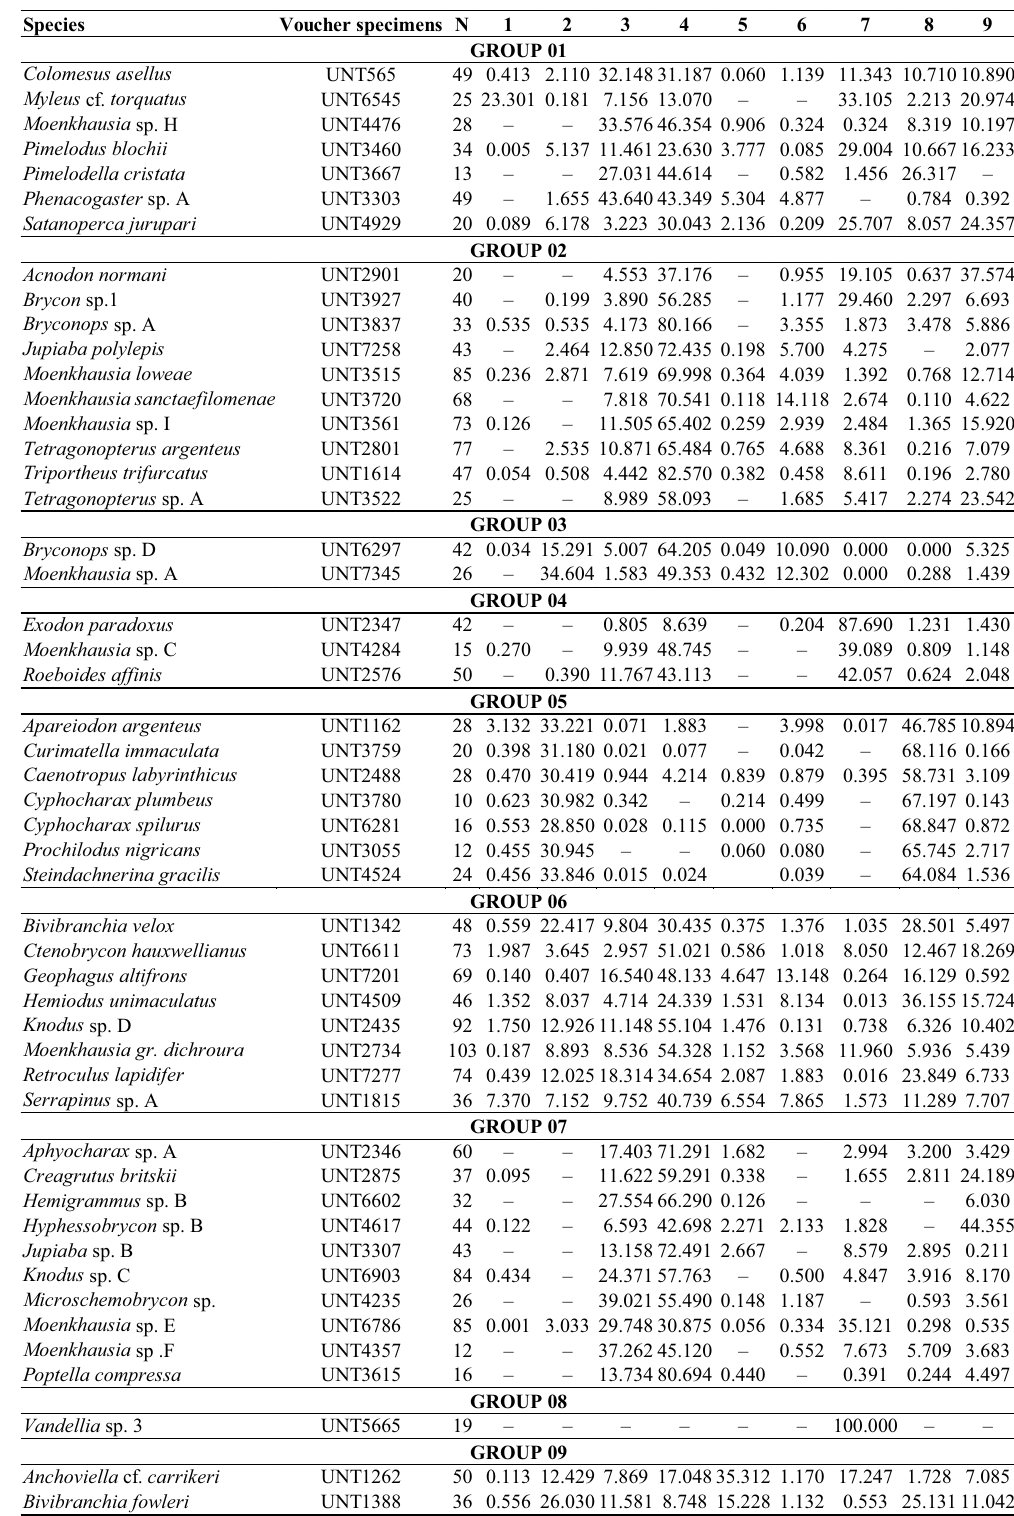
Table 2 . Food resources used by the fish species, estimated by volume. N = number of stomachs examined; 1 = Algae; 2 = Detritus; 3 = Aquatic Insects; 4 = Terrestrial Insects; 5 = Microcrustaceans; 6 = Other Invertebrates; 7 = Fishes; 8 = Sediment; 9 = Plant Matter; – = absence of